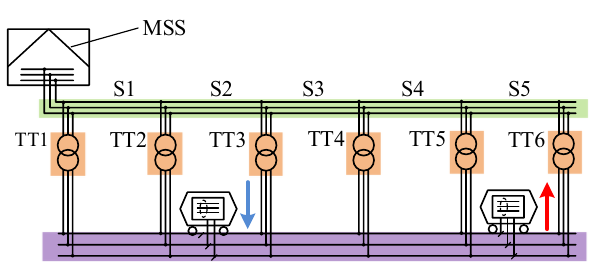
Fig. 20 Schematic diagram of locomotive layout